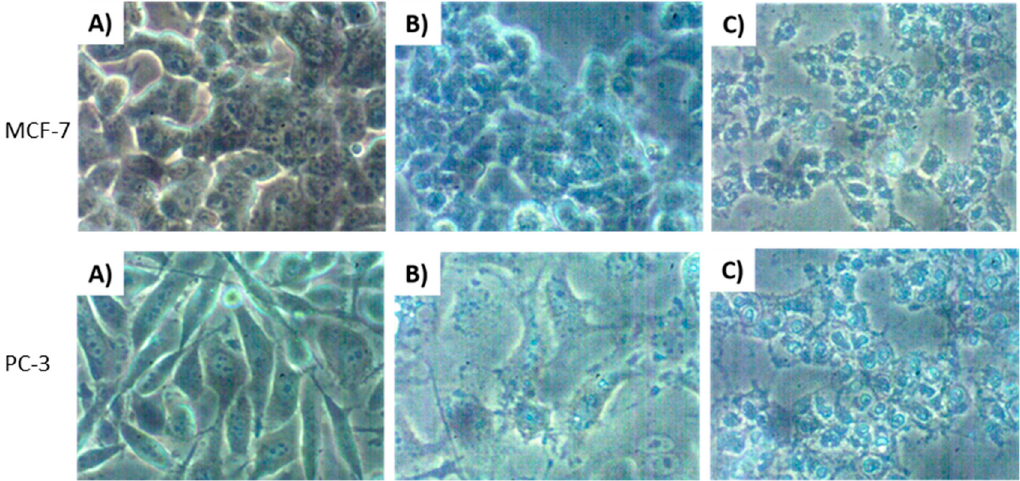
Figure 6. Morphological changes in MCF-7 and PC-3 cells 24 h after treatment. Cells in ( A ) were left untreated, while cells in ( B ) represent the cells treated with 60 μ M ceramide and ( C ) cells treated with 100 μ M of variabilin. Cellular morphology was observed and captured at 20× magnification using an inverted (Nikon) light microscope.